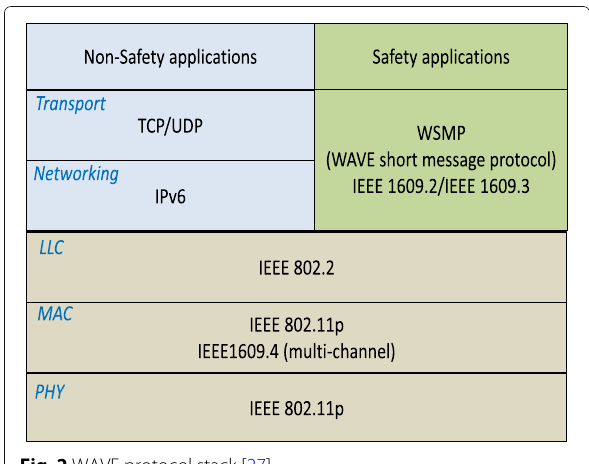
similar to Distributed Coordination Function (DCF) in IEEE 802.11. One important difference between EDCA and DCF is that the inter-frame spacing interval in EDCA can be arbitrary (AIFS), allowing EDCA to shorten the frame spacing interval for delay-critical applications such as video streaming